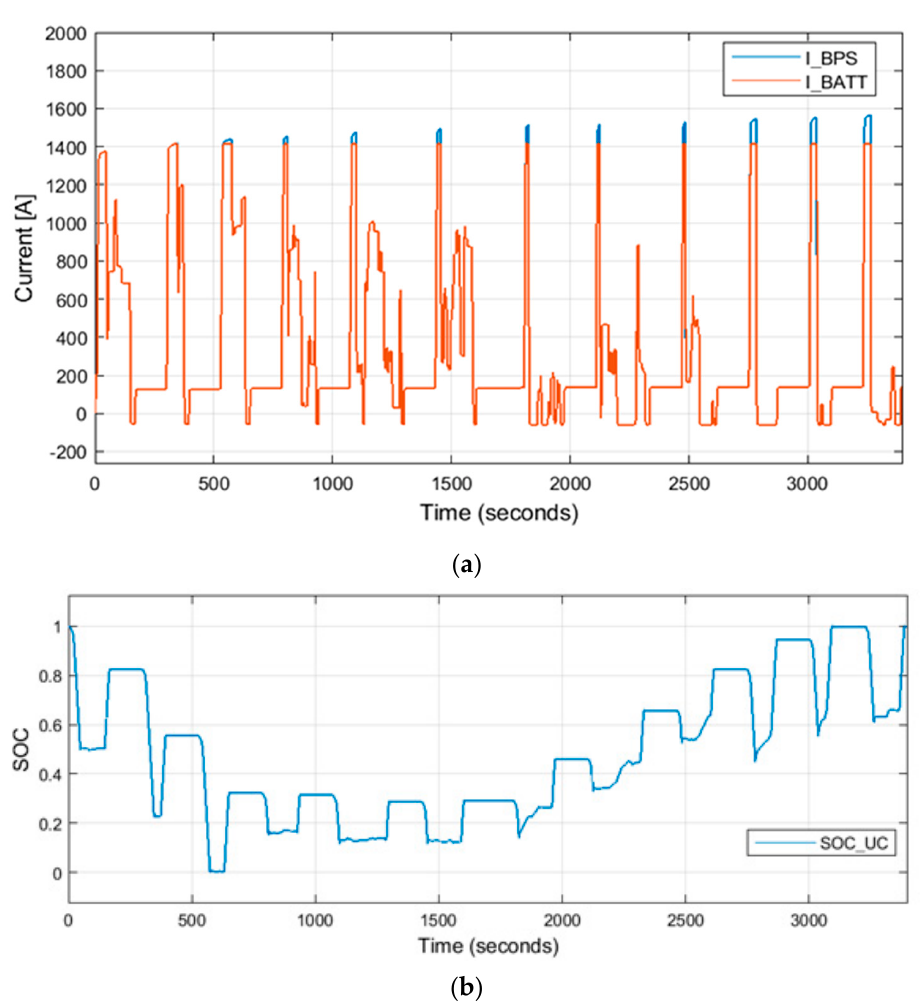
Figure 19. H-ESS: ( a ) Current required to the battery pack; ( b ) Supercapacitor pack SOC.